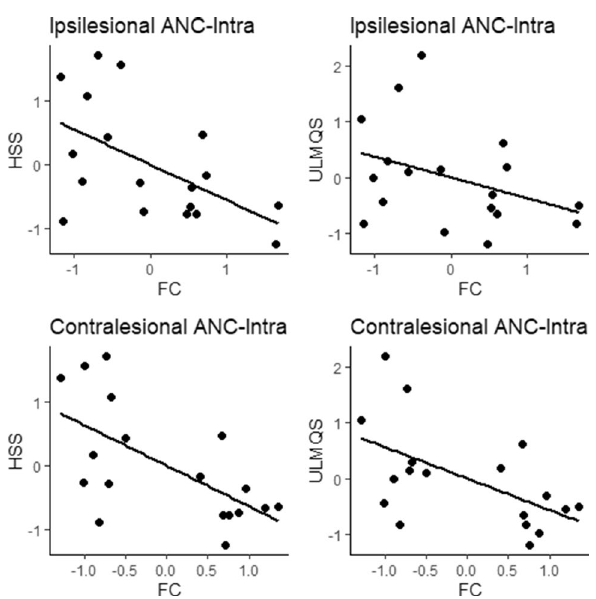
Figure 3. Associations between asymmetry of upper limb function, manual ability, and average network connectivity. Scatter plots depict residuals of the partial correlations between motor assessments (HSS, ULMQS and ABILHAND) and inter-/intrahemispheric average network connectivity with age at assessment, and age at stroke, lesion size as covariates. ANC-intra intrahemispheric average network connectivity, FC functional connectivity, HSS hand strength score, ULMQS Upper Limb Movement Quality